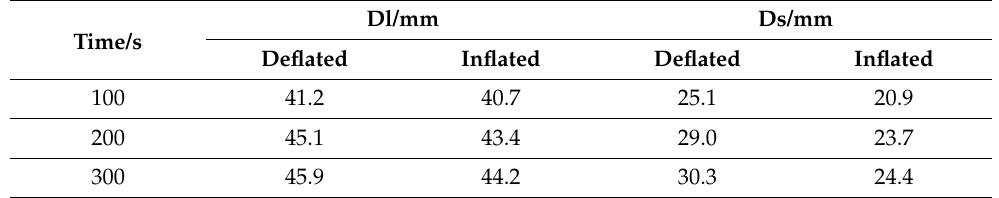
Table 10. Simulation data (ablation power 50 W).